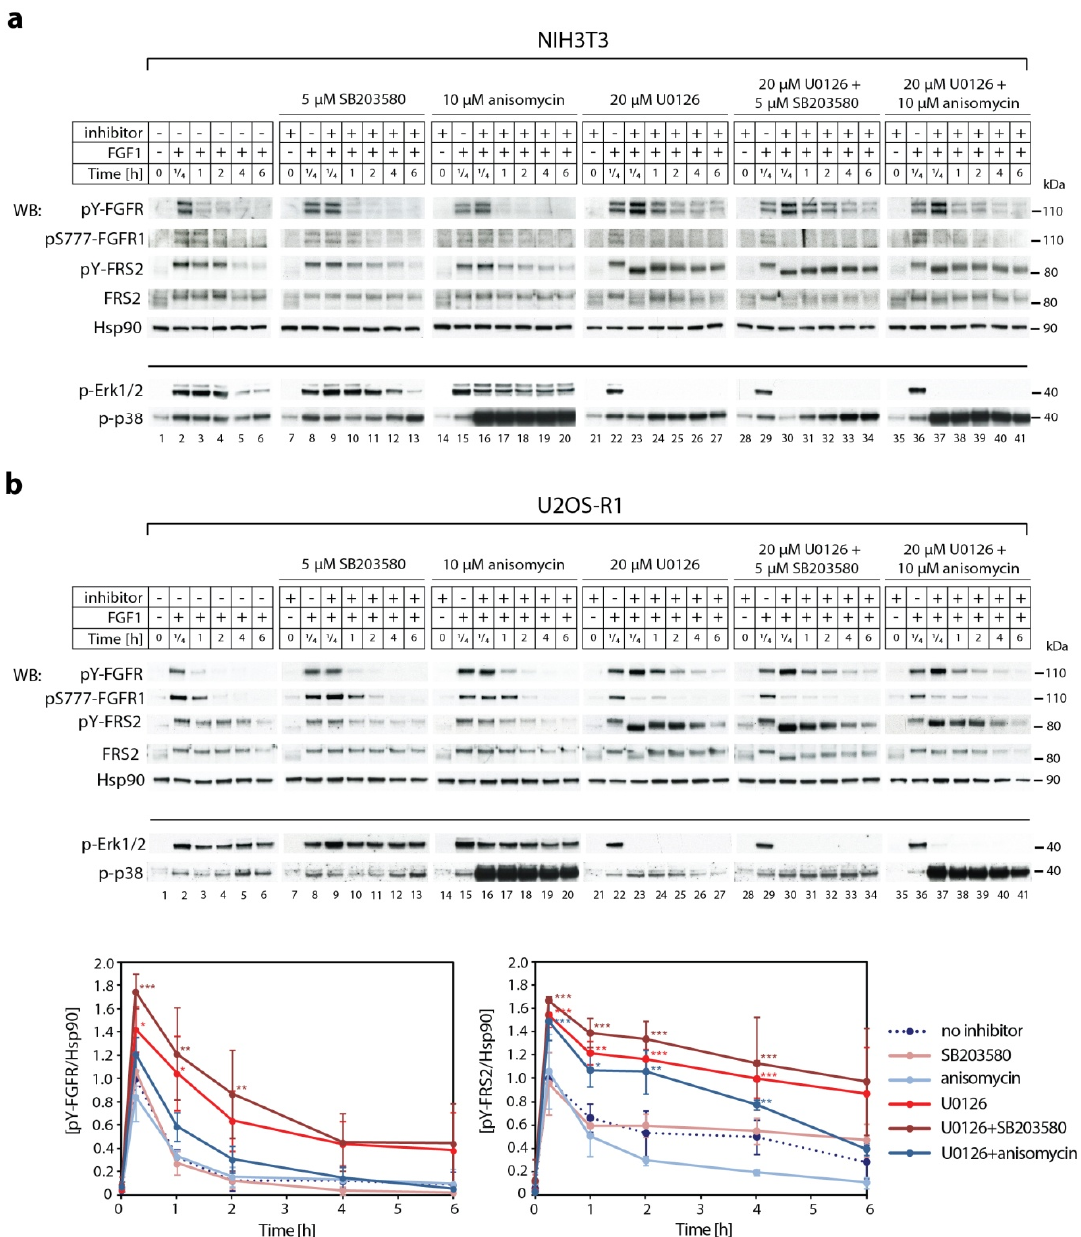
Figure 2. The crosstalk between p38 and Erk1 / 2 in downregulation of FGF1-induced signaling. Serum-starved ( a ) NIH3T3 and ( b ) U2OS-R1 cells were pretreated for 30 min with or without 20 µ M U0126, 5 µ M SB203580 and 10 µ M anisomycin, and then stimulated with the growth factor in the presence of heparin (10 U / mL) and brefeldin A (2 µ g / mL) for di ff erent time points. Cells were lysed, and the cellular material was analyzed by SDS-PAGE and immunoblotting using the following antibodies: anti-phospho-FGFR (Tyr653 / Tyr654) (pY-FGFR), anti-phospho-FGFR1 (Ser777) (pS777-FGFR1), anti-phospho-FRS2 (Tyr196) (pY-FRS), anti-FRS2, and anti-Hsp90 as a loading control. Anti-phospho-Erk1 / 2 (p-Erk1 / 2) and anti-phospho-p38 MAPK (Thr180 / Tyr182) (p-p38) were used to control the e ff ect of U0126 (MEK inhibitor) and anisomycin (p38 activator). Representative experiments are shown, n = 3. The graphs present quantification of bands from panel b corresponding to phospho-FGFR1 (Tyr653 / Tyr654) and phospho-FRS2 (Tyr196) normalized to loading control (Hsp90) and expressed as a fraction of the maximal response in the absence of inhibitor. Data are means ± SD of three independent experiments; * p < 0.05, ** p < 0.01, *** p <